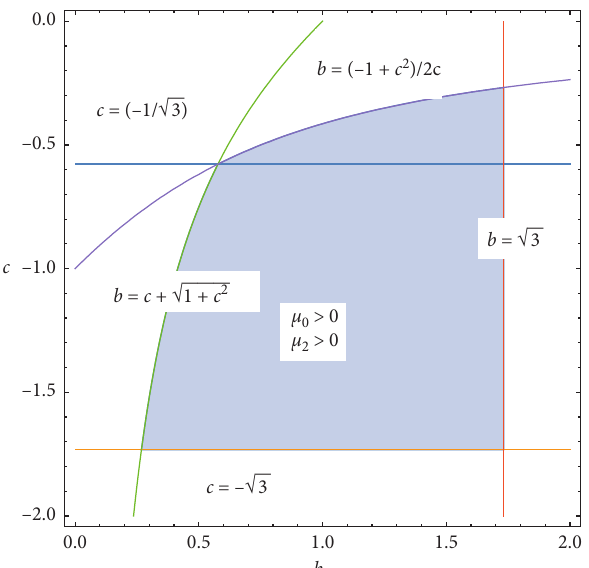
� m � m ≠ m ≠ m . 1 3 0 2